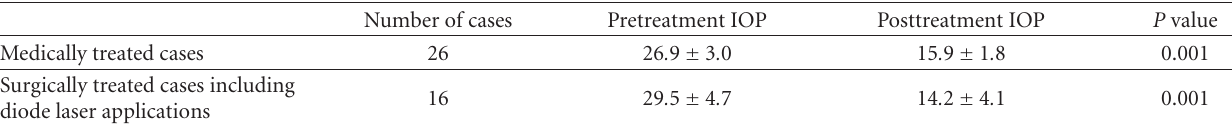
Table 5: The mean pre- and posttreatment intraocular pressures (IOPs) in mmHg.